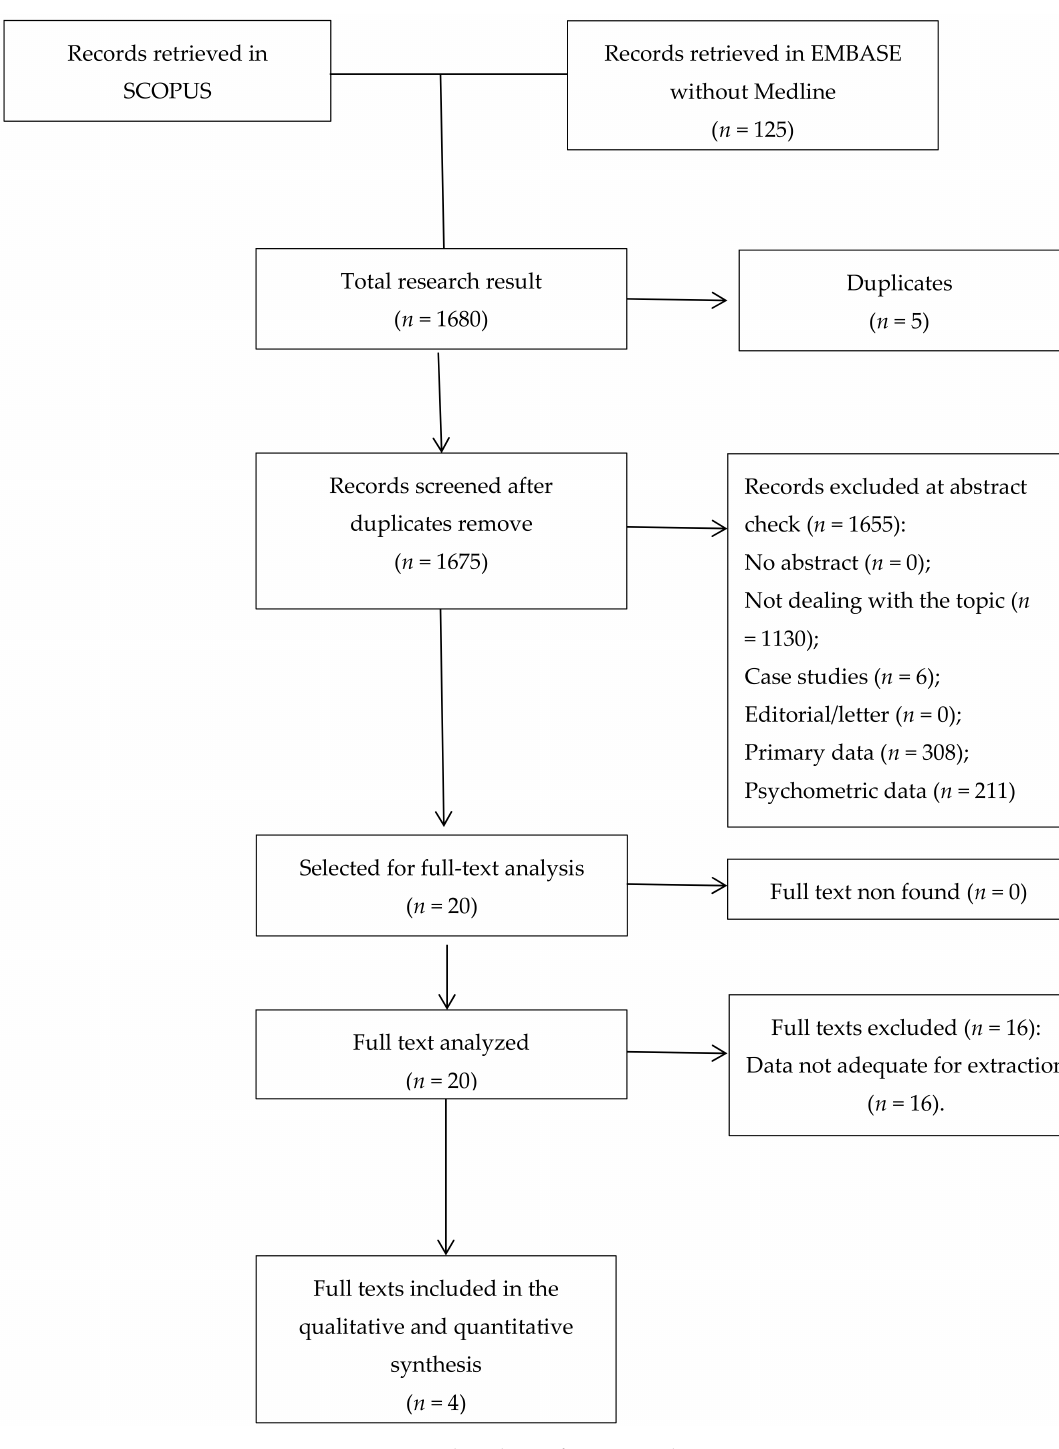
Figure 1. Flowchart of papers’